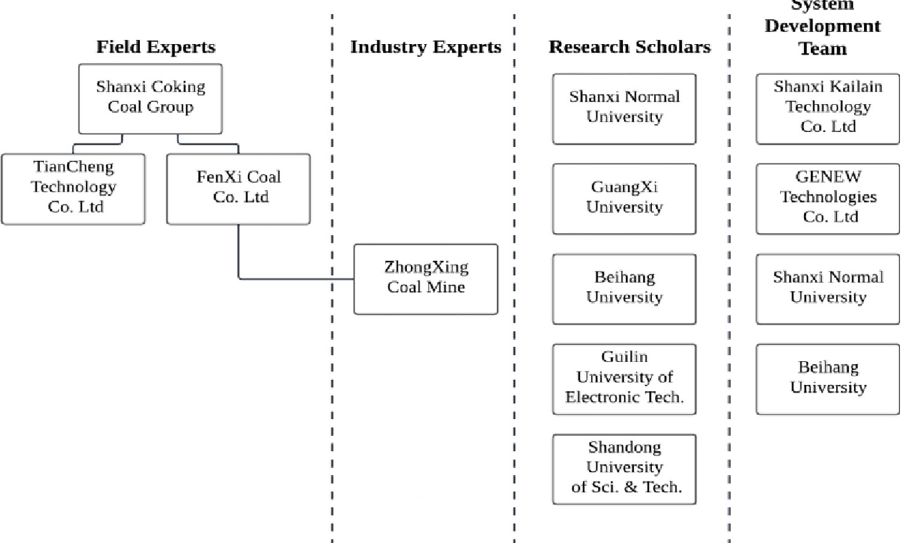
Fig 2. Organizational chart of the project